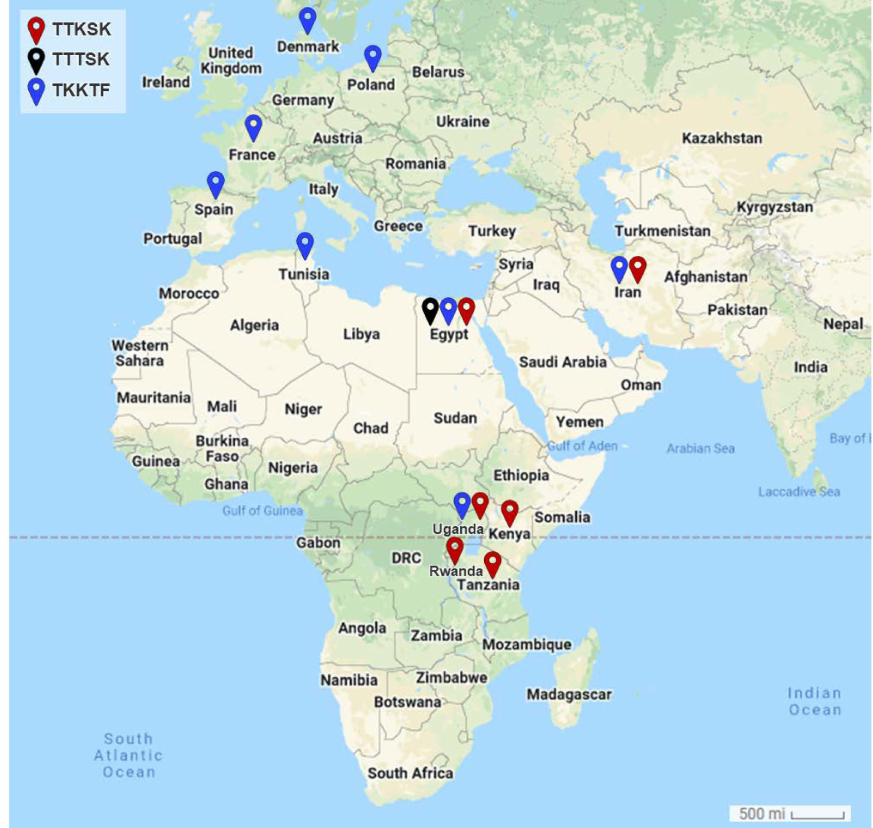
Figure 4. Geographical distribution of the most virulent races; TTKSK, TTTSK, and TKKTF of stem rust pathogen, Puccinia graminis f. sp. tritici in Africa, Asia, and Europe. Red symbols signify TTKST races, black symbols signify TTTSK races, whereas blue symbols signify TKKTF races, see the key at the top left corner of the